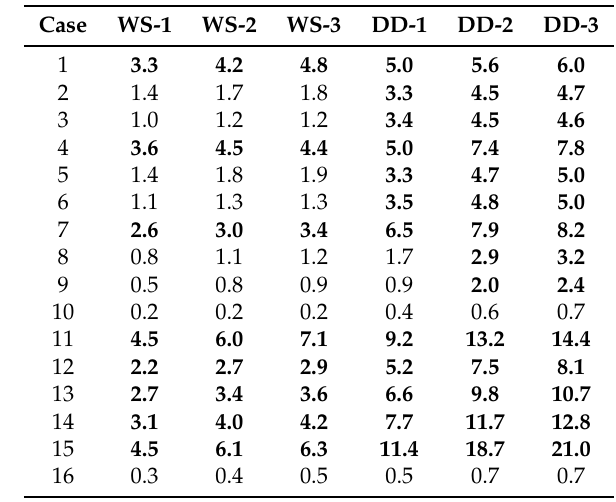
Table 2. Apparent resistivity anomaly magnitudes (in %) for the test cases described in Table 1. Measurement configurations are denoted by WS (Wenner-Schlumberger) or DD (dipole-dipole) followed by the spacing factor ( n = 1,2,3). Values greater than 2.0% are in bold. See Figure 2 for how these values are determined.